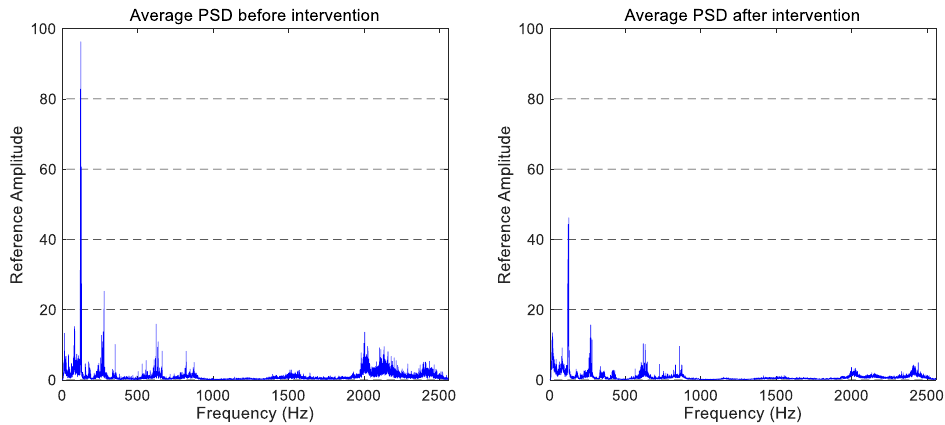
Figure 4. The comparison of the average spectra for vertical accelerations obtained before and after the wheel intervention.